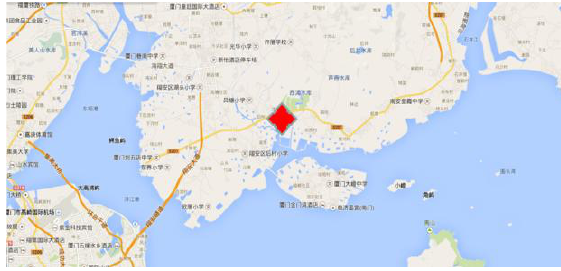
Figure 1. Geographical Location of Tungyuan Village